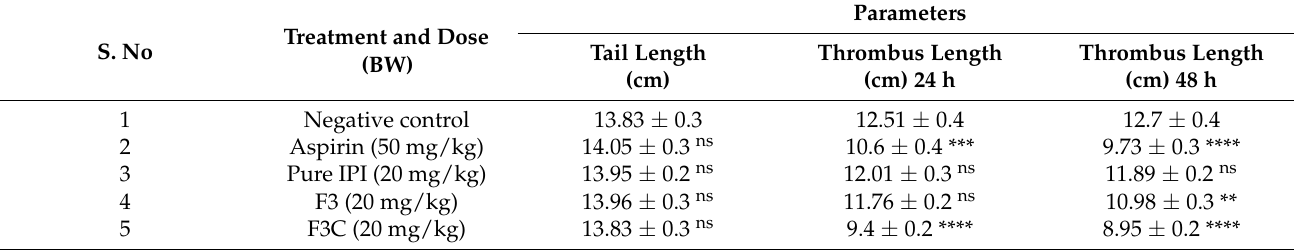
Table 3. Effect of various treatments on thrombus length in Carageenan induced tail vein thrombosis. Data are shown as Mean ± SEM, ( n = 6). ns = non-significant, **** p < 0.0001, *** p < 0.001, ** p < 0.01, where various treatment groups were compared with negative control group.